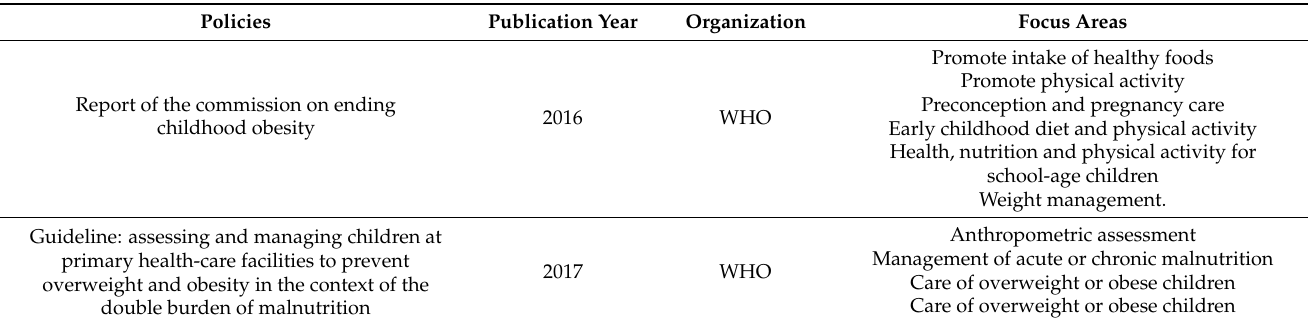
Table 2. Policies for prevention of childhood overweight and